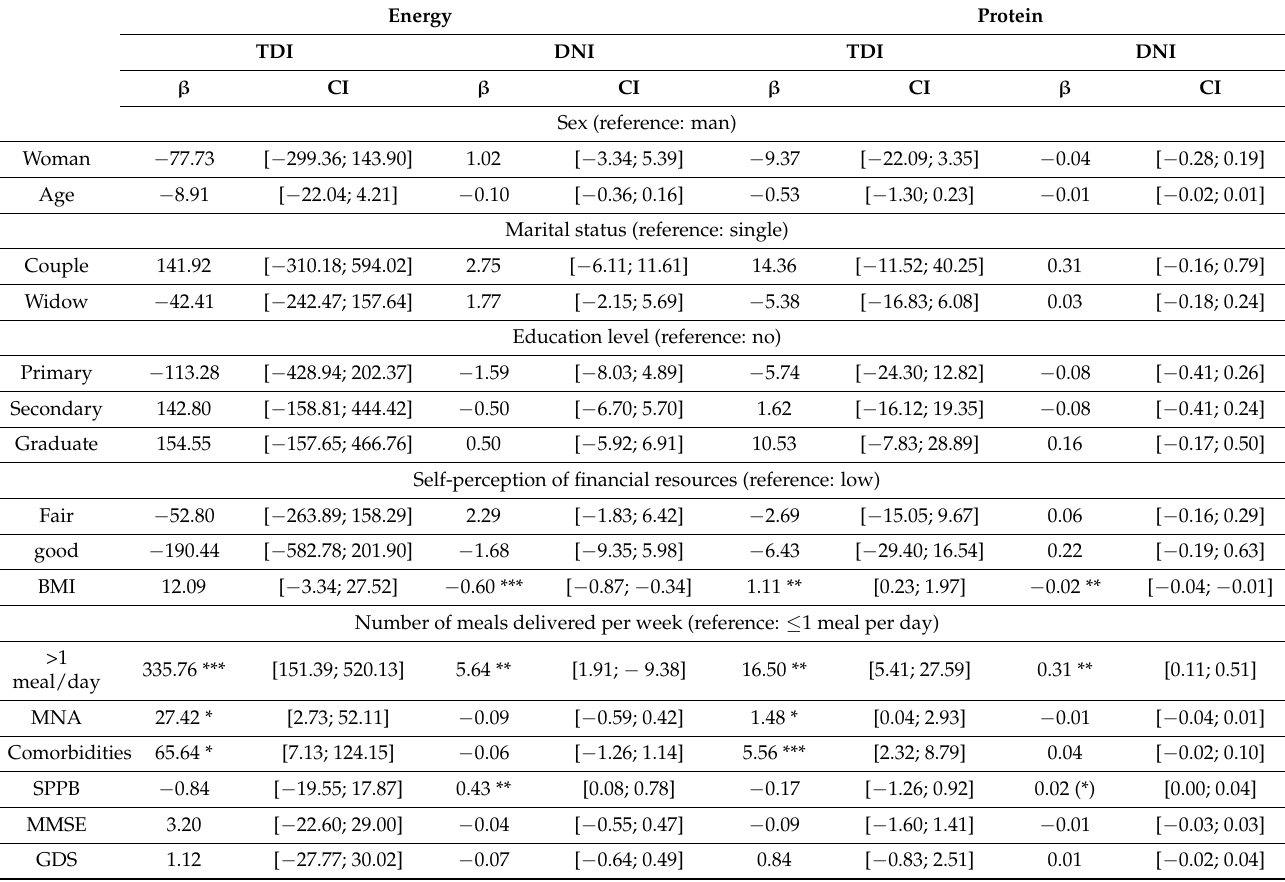
Table 5. The result of analyses in the univariate mixed linear model. The β coefficients are associated with their 5% confidence interval (CI) and the significance threshold: (*): p < 0.10; * p < 0.05; ** p < 0.01; *** p <